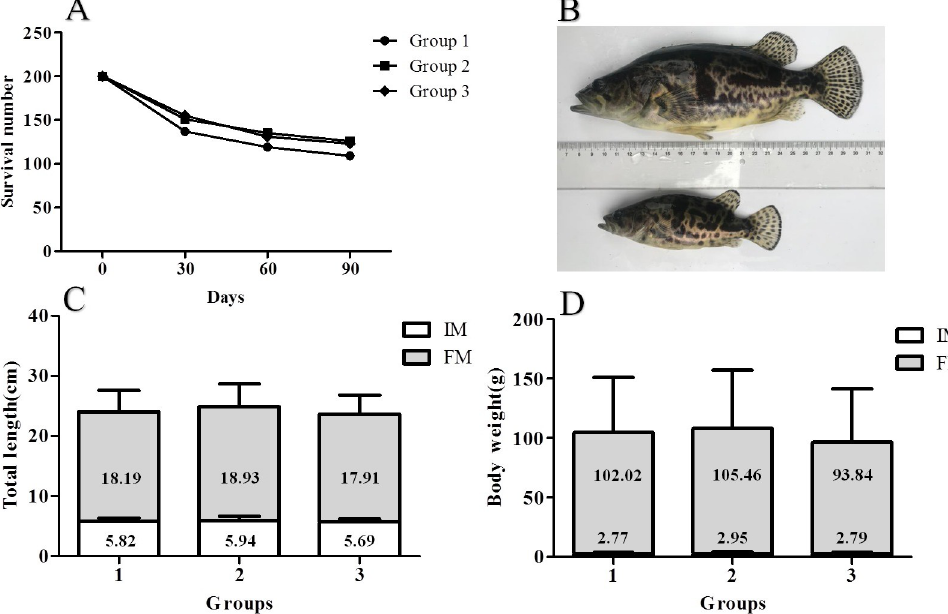
Fig 1. The growth performance of hybrid mandarin fish. ( A ) The survival number of hybrid mandarin fish. ( B ) The morphology of domesticated hybrid mandarin fish. ( C ) The change of total length of hybrid mandarin fish. ( D ) The change of body weight of hybrid mandarin fish. IM, Initial Measurement (0 day). FM, Final Measurement (90days).